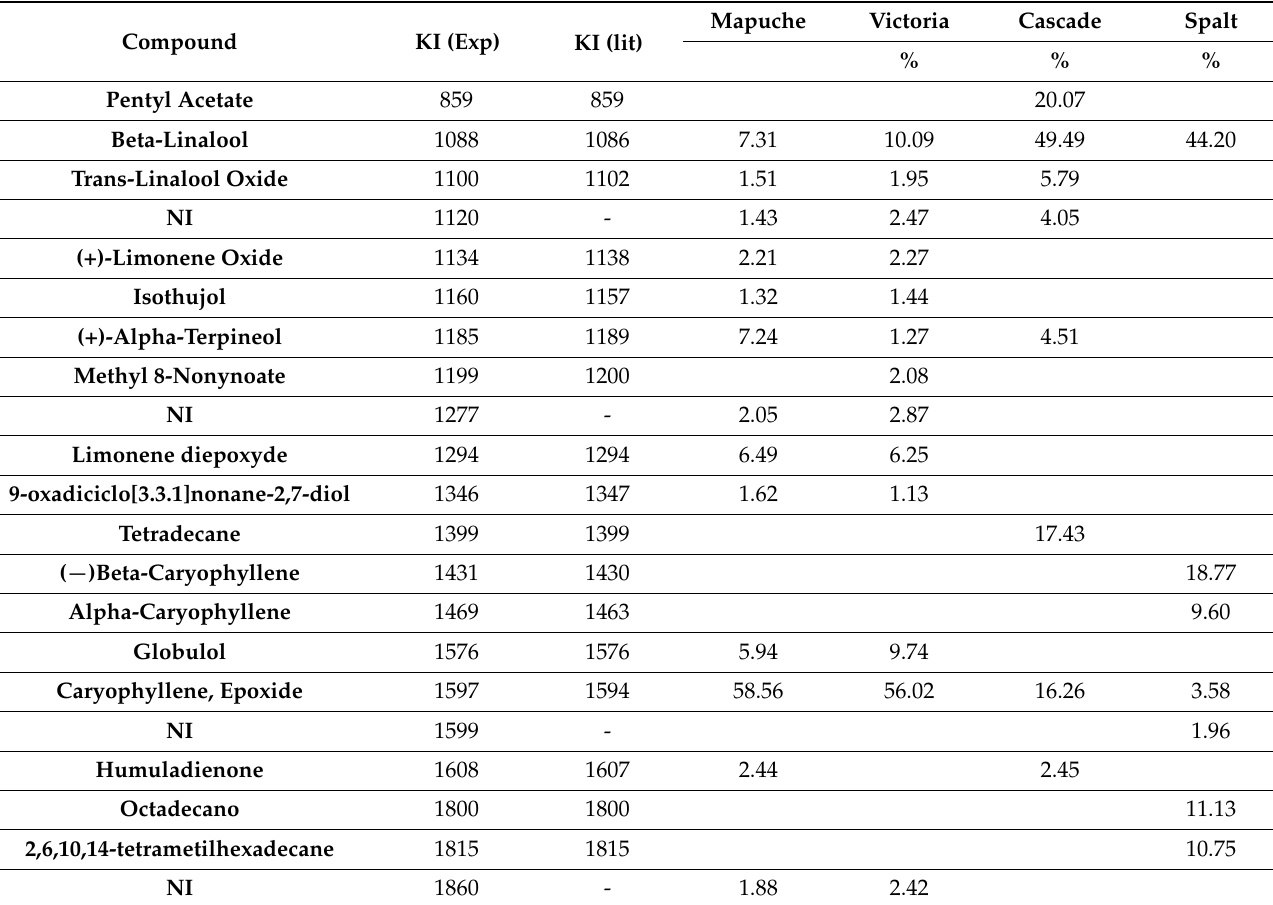
Table 1. Relative percentage compositions of hydrolats from Humulus lupulus female flower cones of Mapuche, Cascade, Spalt, and Victoria varieties.